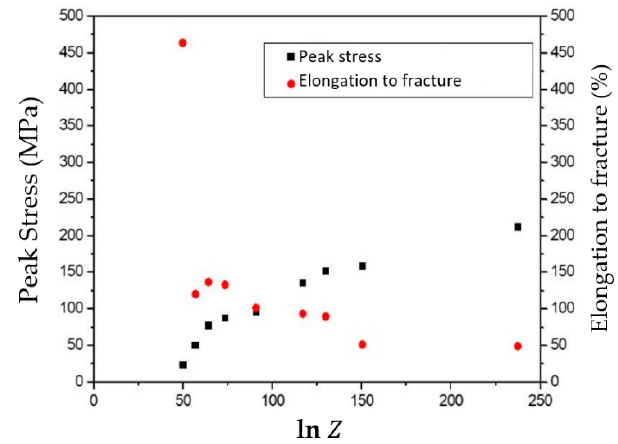
Figure 13. Tensile strength and elongation to failure versus ln (cid:1852) plot.